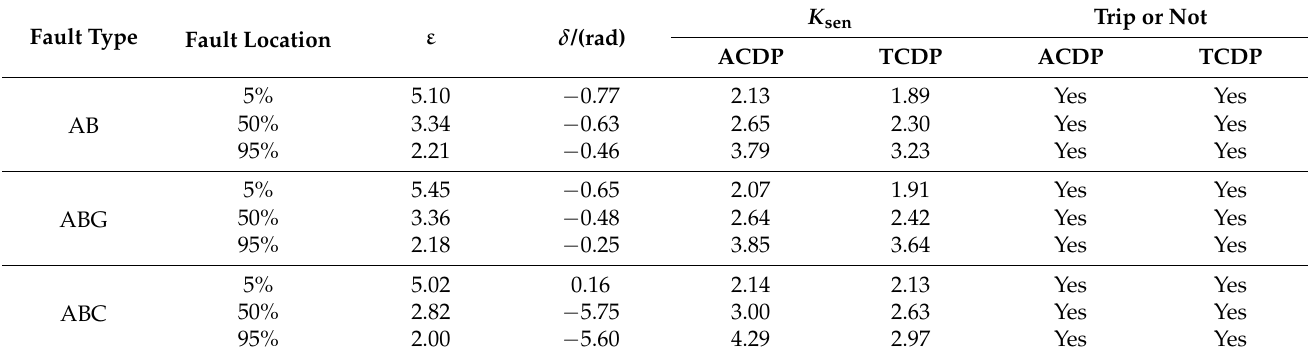
Table 3. Simulation results of metallic multi-phase faults at feeder B 4 B 5 .